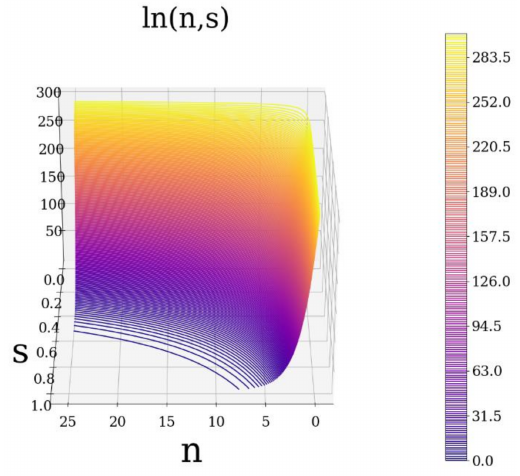
Figure 1. Plot of l n as a function of n and s